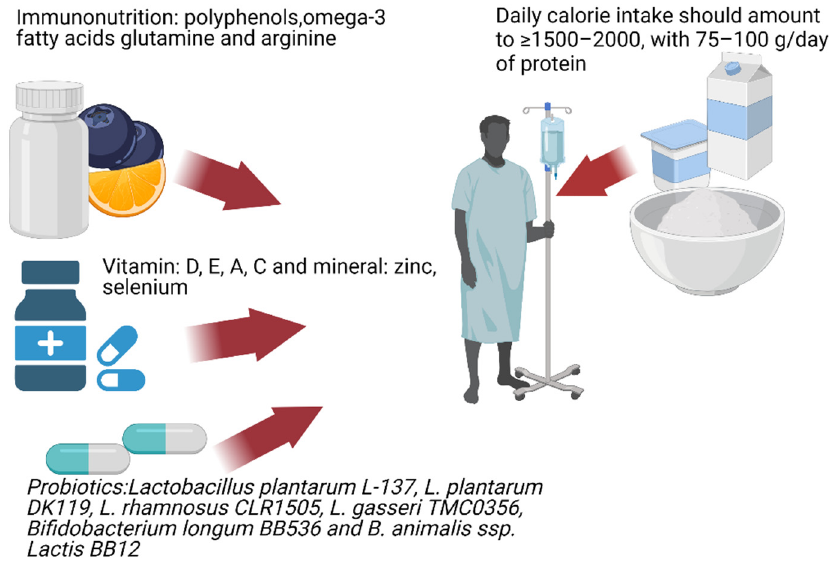
Figure 1. Immunonutrition patients with COVID-19.